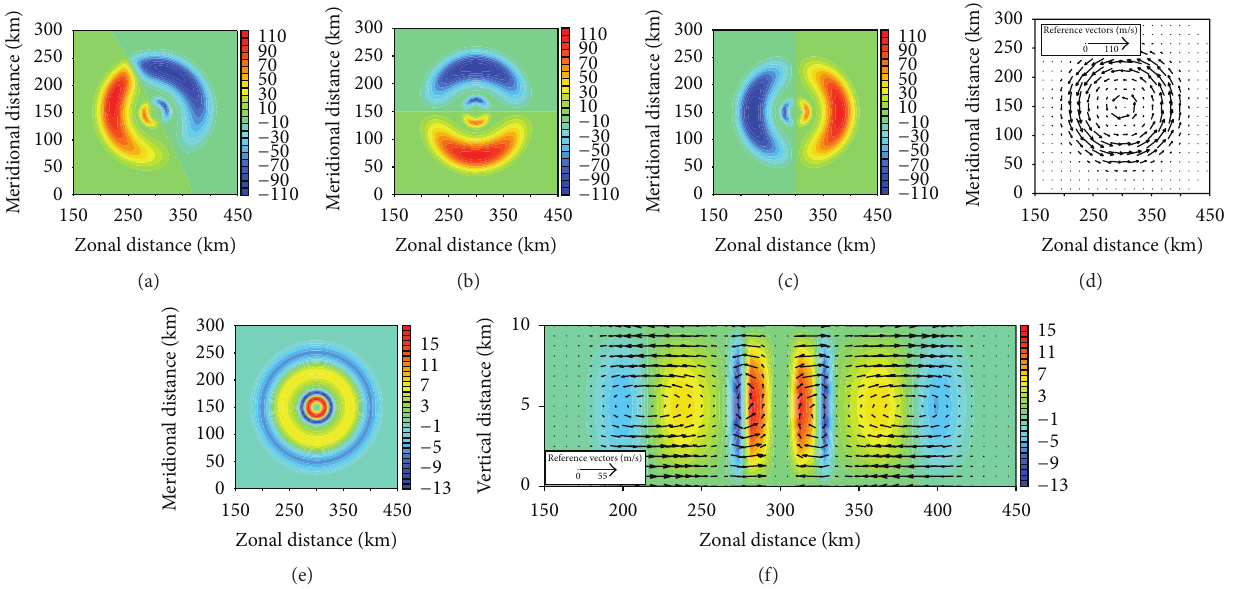
Figure 1: The synthetic “typhoon” field (serving as the “truth”) at middle vertical level (5 km). (a) Radial velocity, (b) U component, (c) V component, (d) wind vector, (e) W component, and (f) W distribution at an 𝑥 - 𝑧 section across the center of the synthetic “typhoon” with black arrows representing wind vector at this section (unit: m/s).